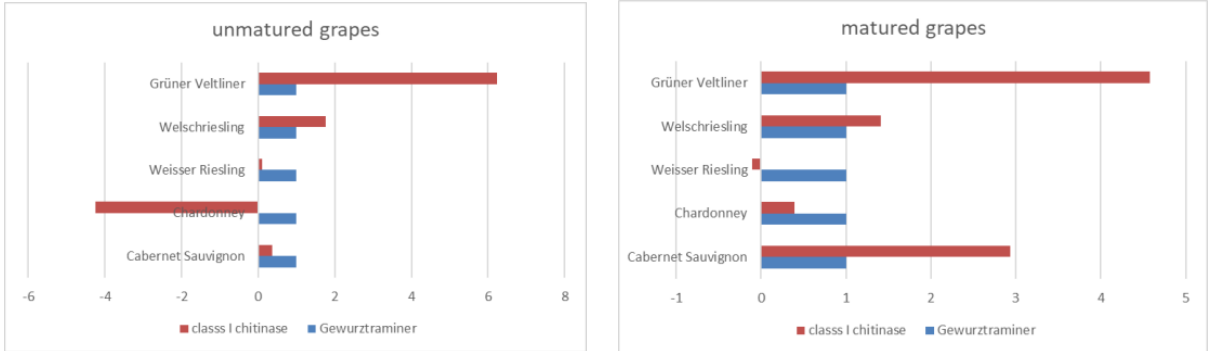
Figure 4. Comparison of expression profiles of unmatured and matured grapevine varieties analysed in the study.